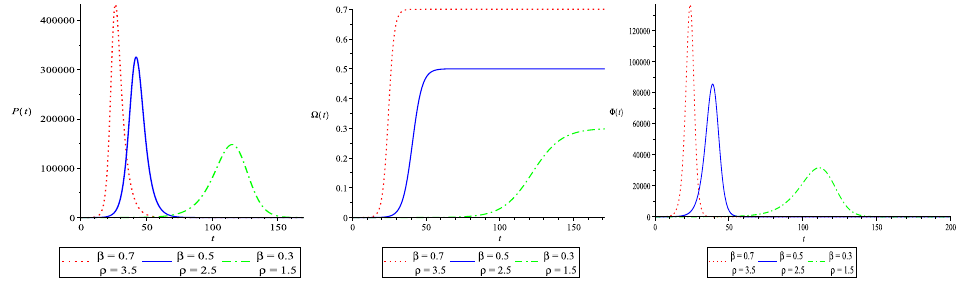
Figure 1. The effect of lockdown on EP, FOI and ROI for N = 10 6 and 0 ≤ t ≤ 200. The value of γ = 0.2 is fixed and, to lower the basic reproduction number, the value of β is reduced. We used S ( 0 ) = 10 6 − 5, A ( 0 ) = 2, I ( 0 ) = 3 and Q ( 0 ) = 0. The parameters are measured in (day − 1 ) . The time t is taken on the horizontal axis and is measured in days.